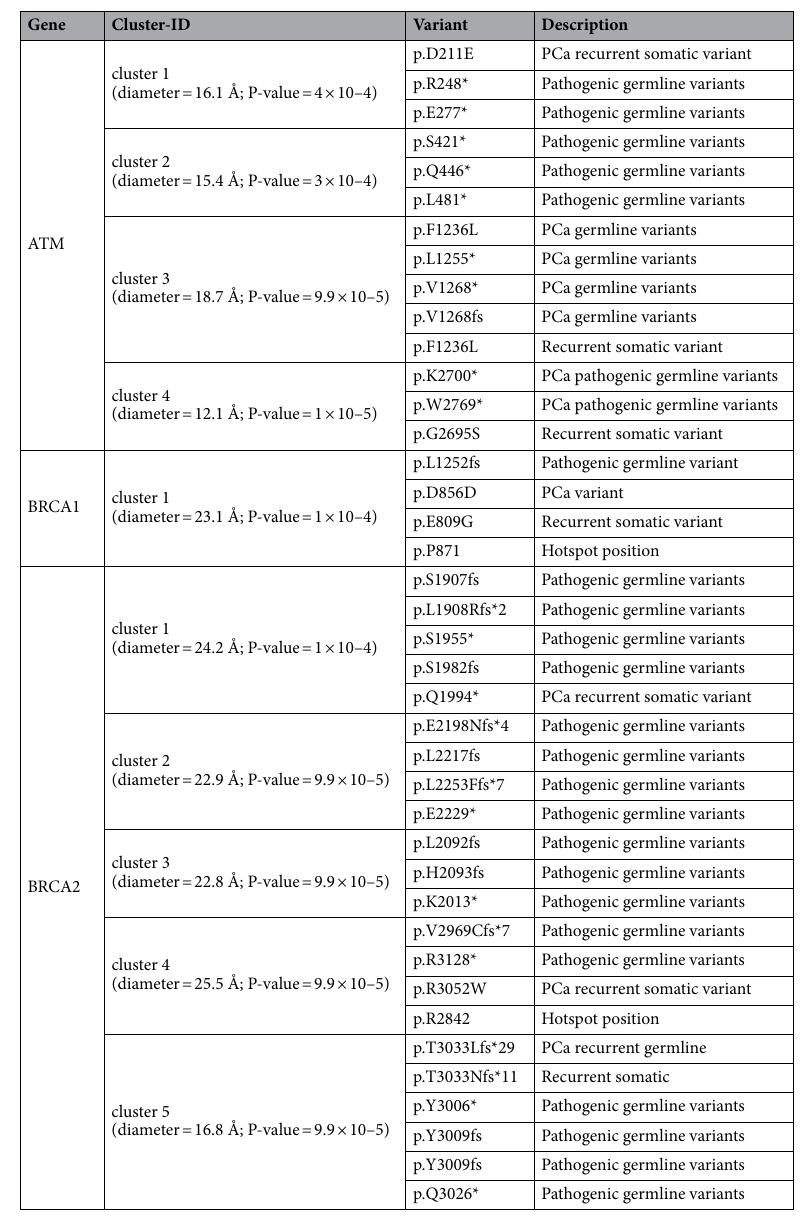
Table 4. List of 3D clusters identified in the protein structure of ATM, BRCA1, BRCA2 and